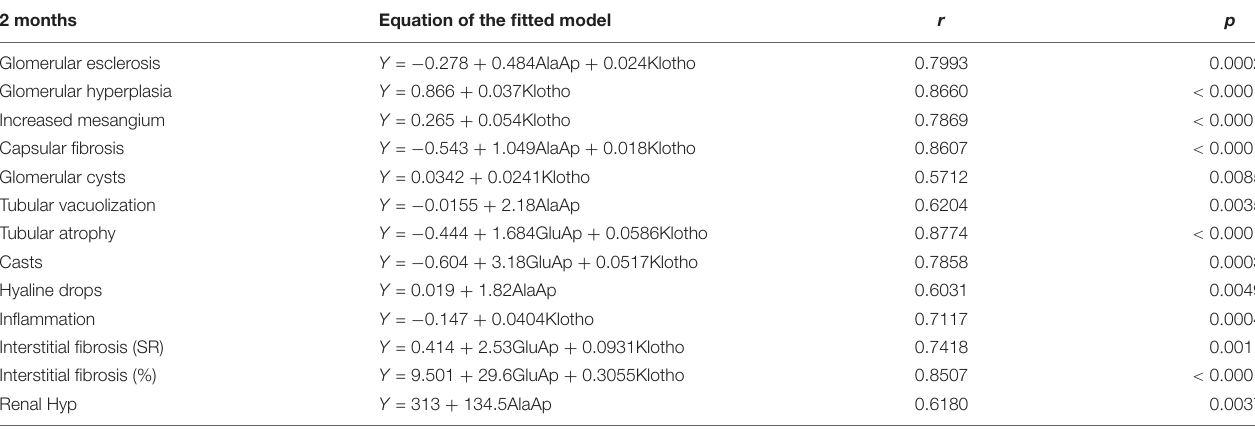
TABLE 5 | Equation of the fitted model, correlation coefficient ( r ) and p -value of the multiple linear regression between urinary markers measured at 2 months and renal lesions at the end of the experiment (8 months old) in Zucker lean and Zucker obese rats ( n = 20).